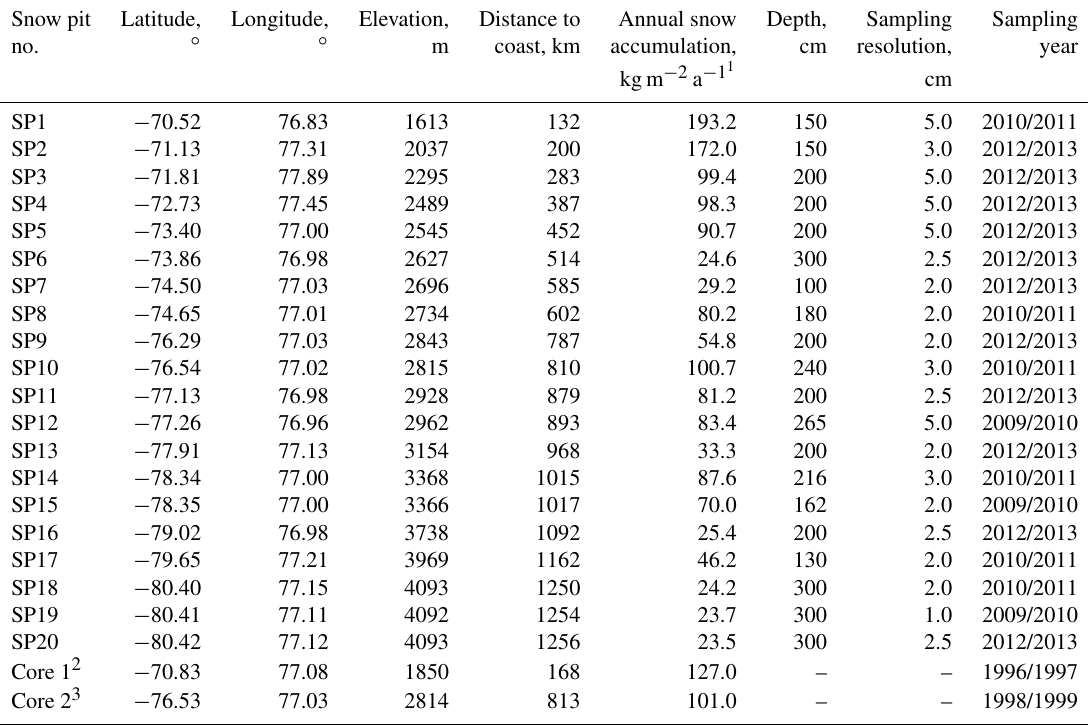
Table 1. Snow pit information on the traverse from coastal Zhongshan Station to Dome A, East Antarctica. Snow pit Latitude, Longitude, Elevation, Distance to Annual snow Depth, Sampling Sampling no.